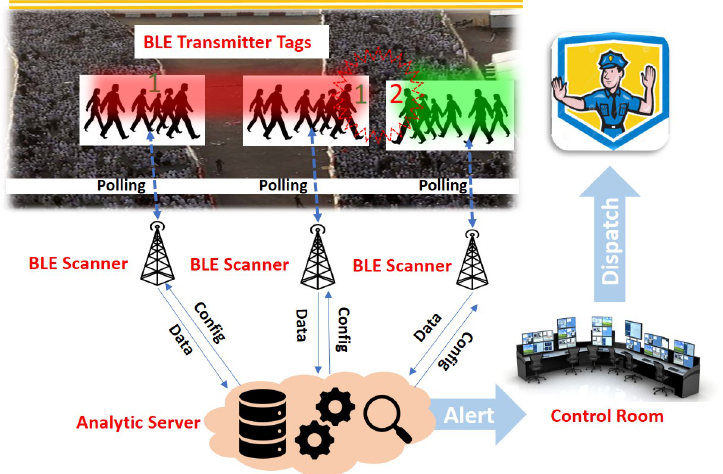
Figure 11. ICE-MoCha Deployment and